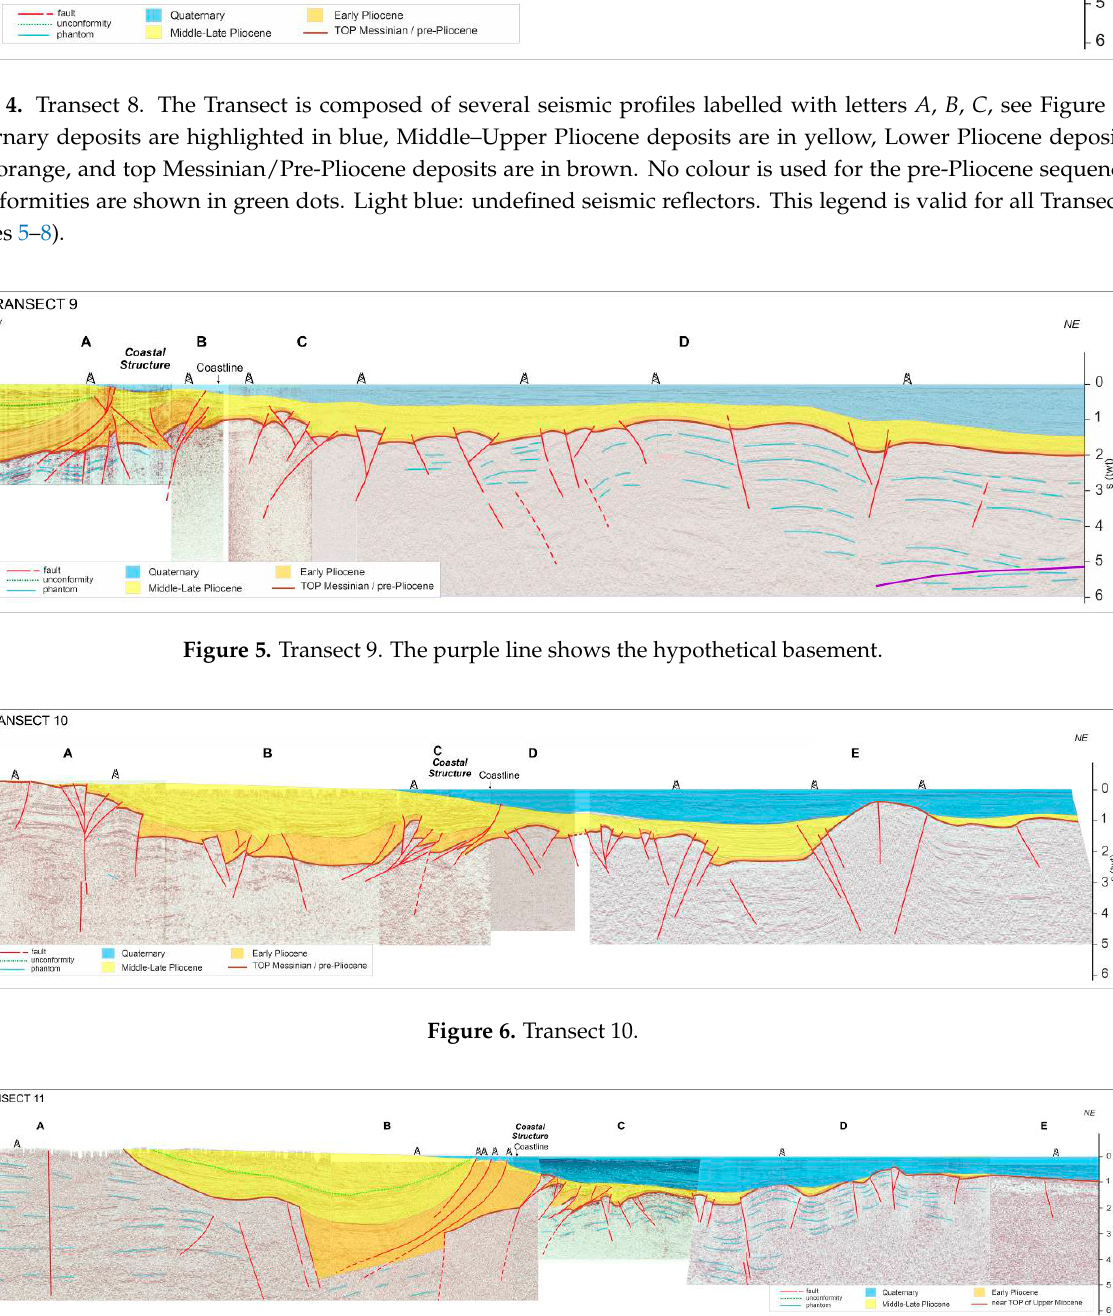
Figure 7. Transect 11.